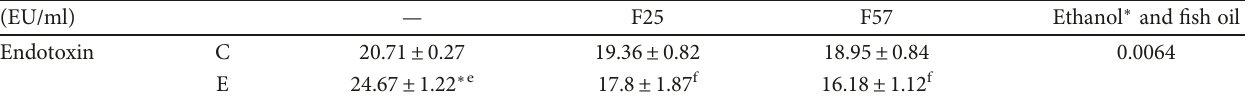
Figure 4: IHC staining of the tight junction protein, ZO-1, in the small-intestinal mucosa in each group. C: control group; CF25: control diet with fi sh oil substituted for 25% of olive oil; CF57: control diet with fi sh oil substituted for 57% of olive oil; E: ethanol group; EF25: alcohol- containing diet with fi sh oil substituted for 25% of olive oil; EF57: alcohol-containing diet with fi sh oil substituted for 57% of olive oil. (a) Representative histological images of rats in all groups at 200x magni fi cation. Arrows indicate ZO-1-positive areas. The normal small intestine exhibited intact epithelium with marked dark-brown ZO-1 expression. (b) Quanti fi cation of ZO-1-immunoreactive areas among groups. Bars with di ff erent letters (A, B) signi fi cantly di ff er among groups C, CF25, and CF57 at the p < 0 05 level according to a one-way analysis of variance (ANOVA) followed by Duncan ’ s new multiple range test. Table 8: Plasma endotoxin levels in each group 1,2